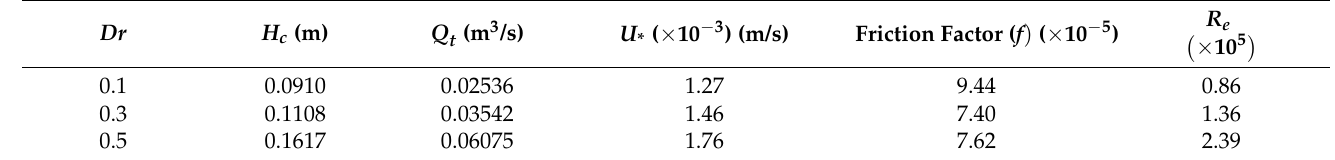
Table 1. Flow conditions of test cases. Note that Q t is the total discharge and R e denotes the Reynolds number.